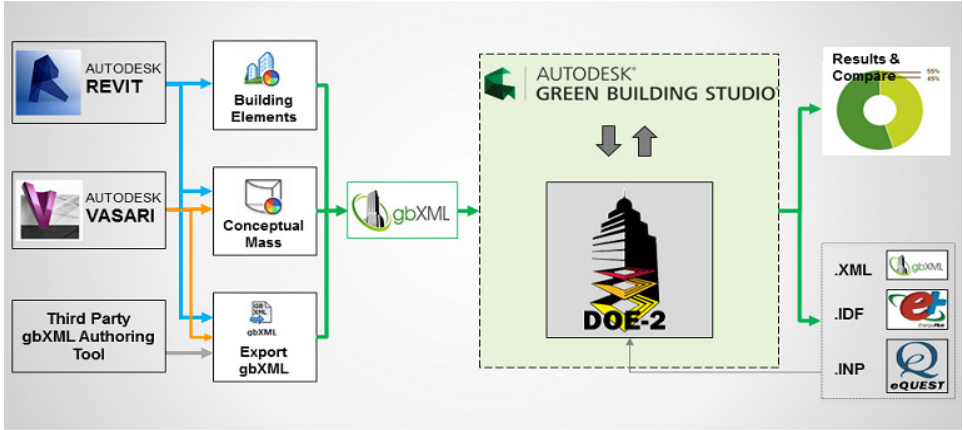
Figure 4. Autodesk@GBS Simulation Engine Block Diagrams use with Autodesk permission Autodesk@GBS Simulation Engine Block Diagrams use with Autodesk (Reproduced with permission from [50]. Autodesk, 2019)